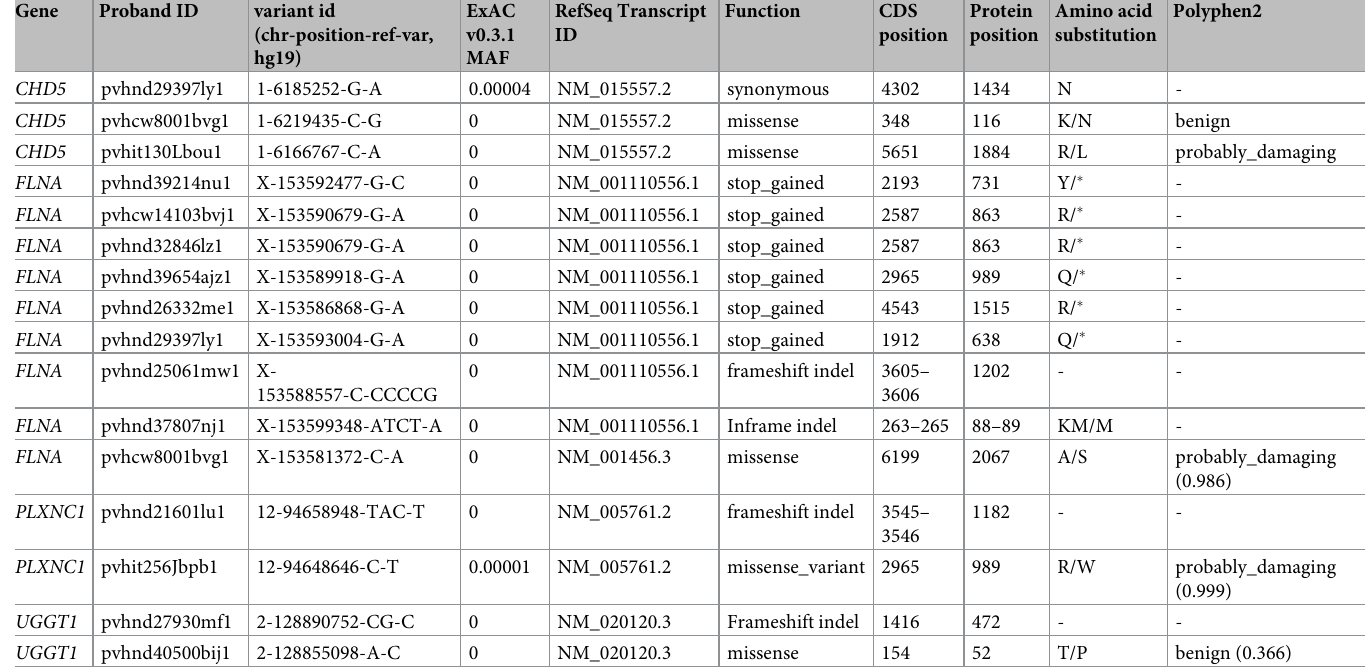
Table 1. Genes with multiple de novo